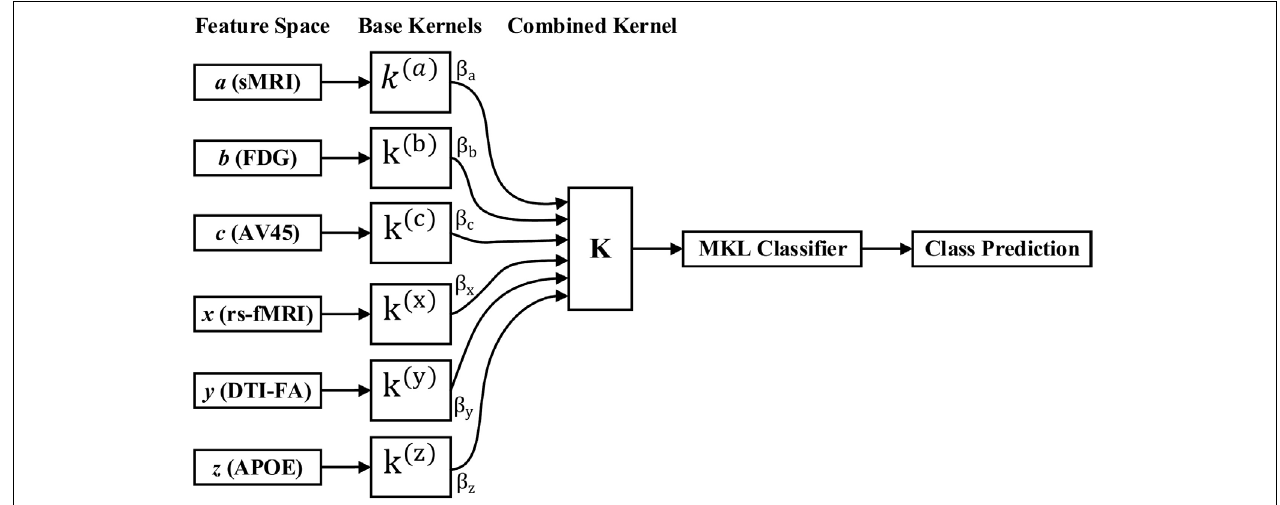
FIGURE 3 | MKL classification